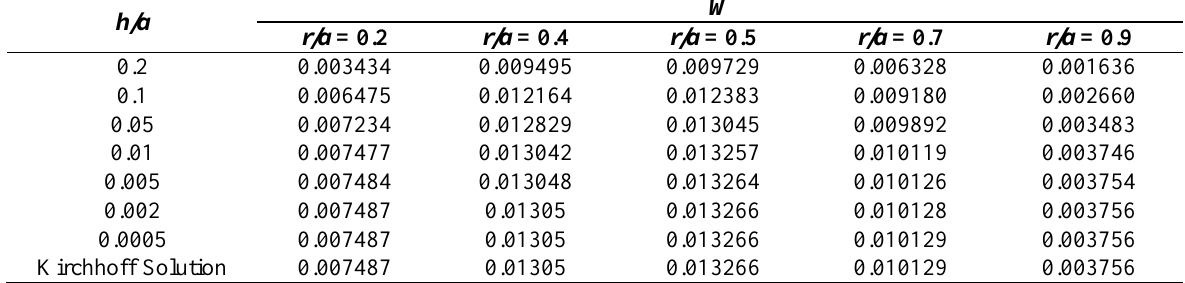
Table 3. Deflection at several points of the plate with thickness ratio h/a ranging from 0.0005 to 0.2